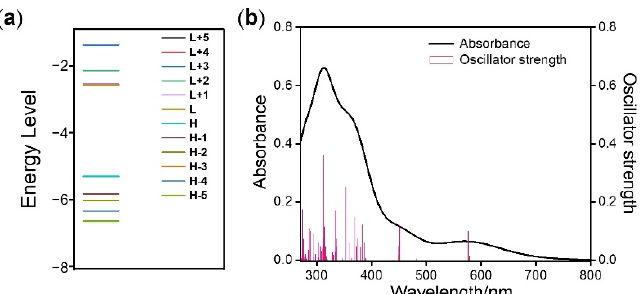
Figure 3. ( a ) DFT-calculated FMO energy diagram. ( b ) Absorption spectra for complex 4 calculated on the basis of TDDFT.